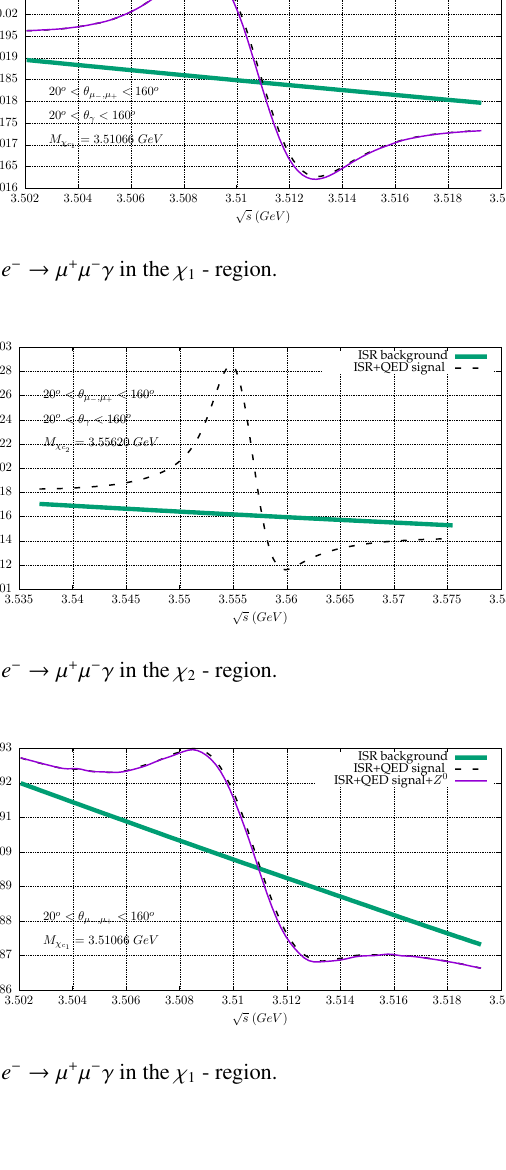
Figure 5. The cross section e + e −